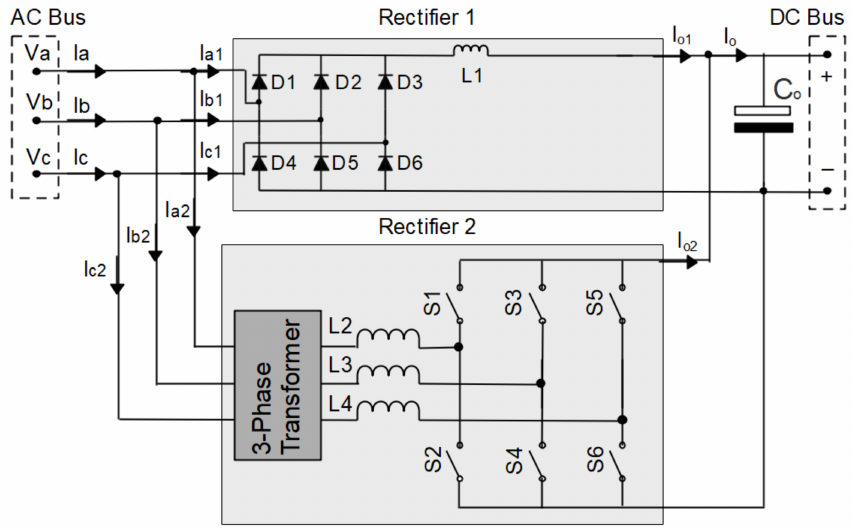
Figure 26. Configuration of the BHTR-R1//BR2 electrical